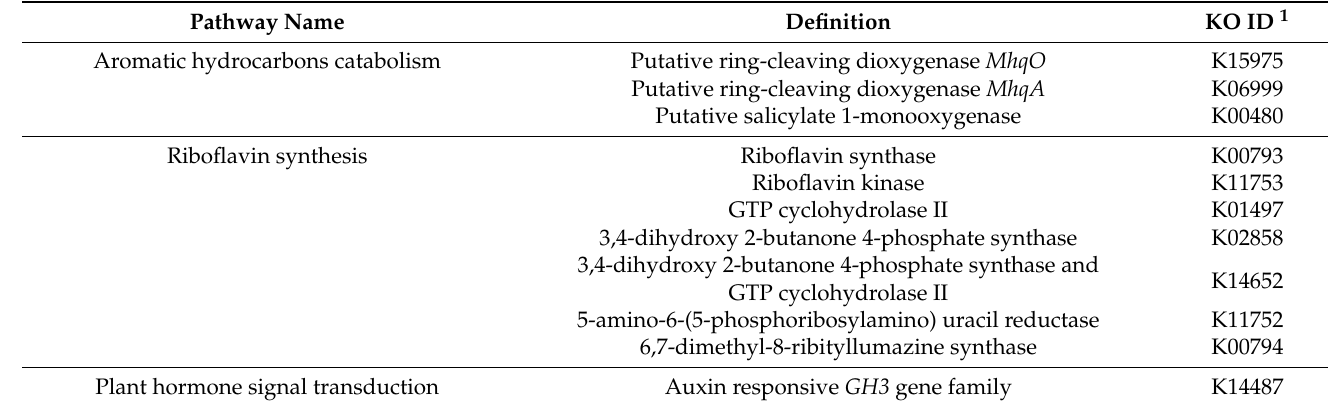
Table 1. Genes involved in carbofuran, naphthalene, aminobenzoate degradation and indole-3-acetic acid (IAA) production by Chryseobacterium sp. BSC2-3 and their associated pathways sorted with KEGG orthology (KO) terms.